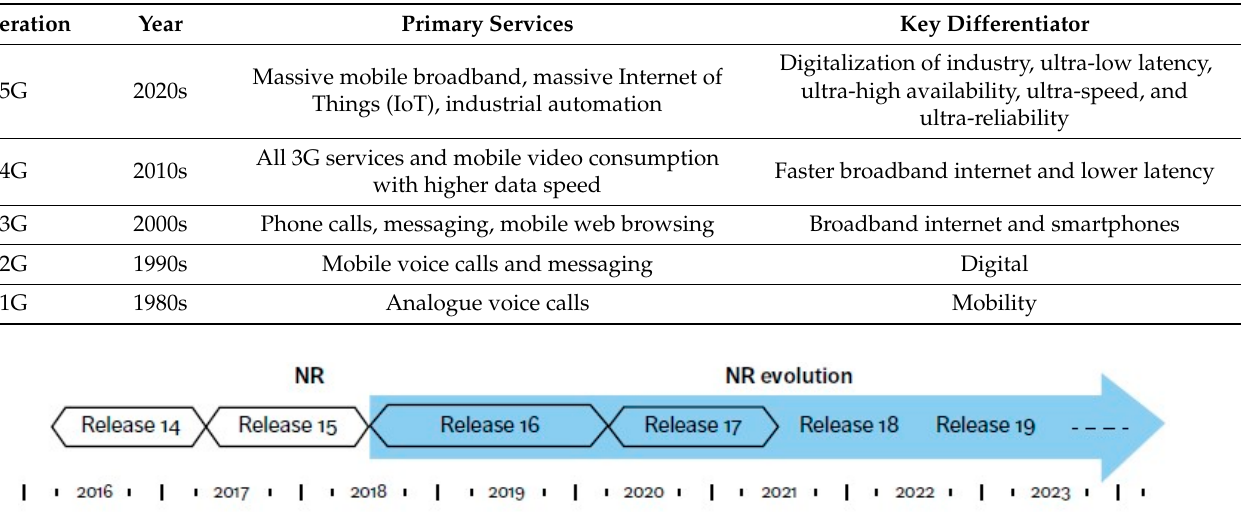
Figure 1. 5G NR evolution time